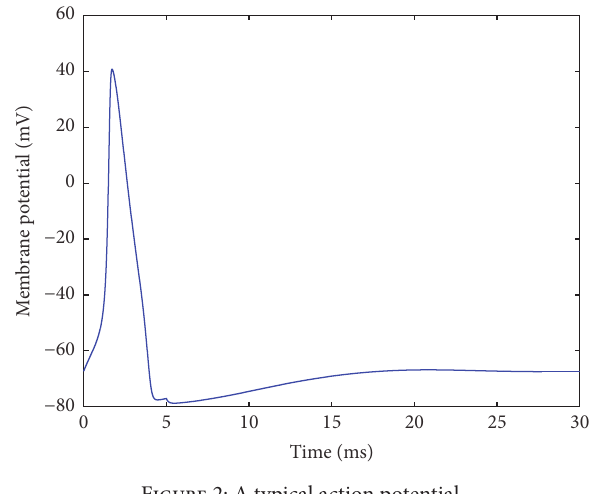
Figure 2: A typical action potential.